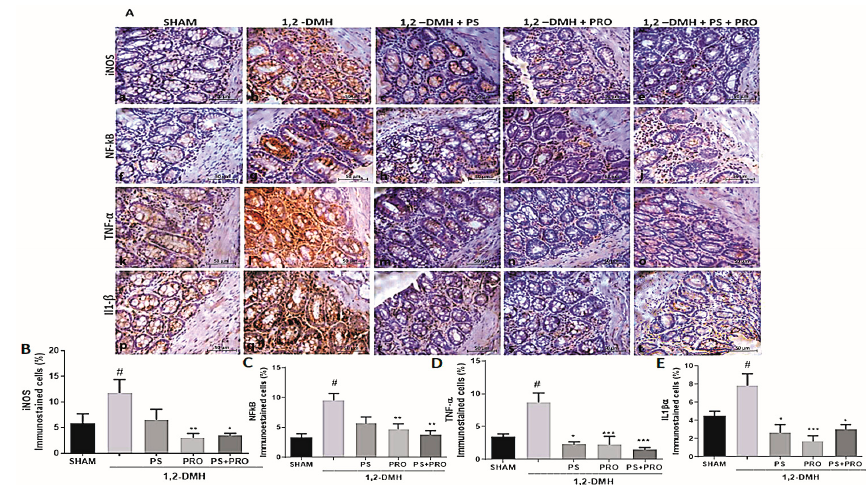
Figure 4. Immunoexpression of iNOS, NF-kB, TNF- α , and IL1 β proteins in the distal colon segment. ( A ) Representative histology of iNOS, NF-kB, TNF- α , and IL1 β immunolabeling in the experimental groups. The graphs ( B – E ) represent the mean ± SEM of the percentage of the immunopositive area for iNOS, NF-kB, TNF- α , and IL1 β in relation to the total area. # p < 0.05 vs. Sham and * p < 0.05, ** p < 0.01, *** p < 0.001 vs. 1,2-DMH group. ( B , D ) The data were analyzed using the Kruskal–Wallis test followed by the Dunn’s post-test. ( C , E ) The data were analyzed by the one-way ANOVA test followed by Tukey’s post-test.